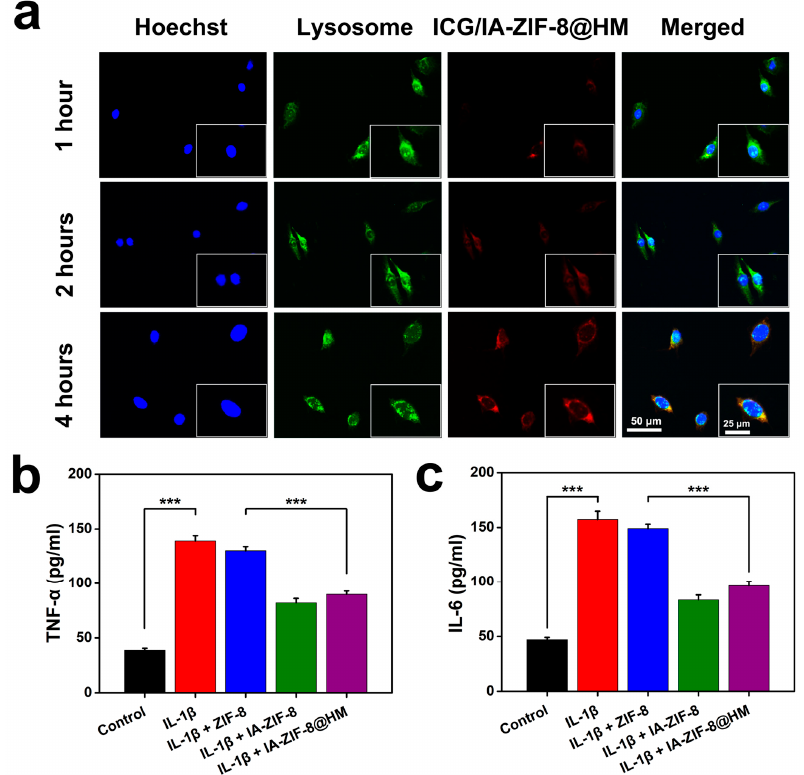
Figure 3. Endocytosis and anti-inflammatory effect of composites. ( a ) The fluorescent microscope images of ATDC5 cells co-cultured with ICG/IA-ZIF-8@HM for 1, 2, and 4 h. ( b , c ) Enzyme-linked immunosorbent assay (ELISA) analyses of TNF- α ( b ) and IL-6 ( c ) concentration in cell supernatants (*** p < 0.001).